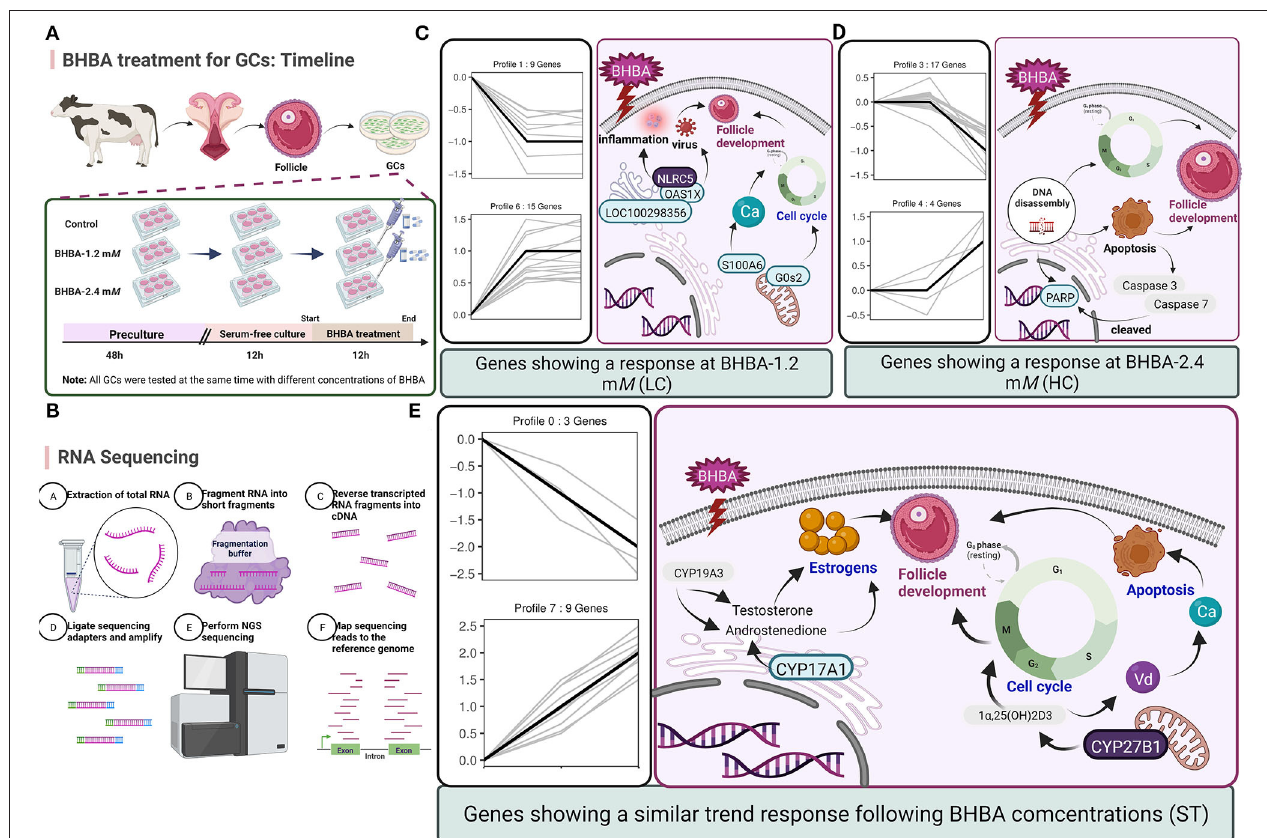
FIGURE 9 | (A) Timeline of BHBA treatment for GCs. (B) The process used for RNA-seq. (C–E) Predicting the regulatory effects on GCs and follicle development exerted by the major DEGs in three expression patterns (including LC response, HC response, and ST response). Up-regulated DEGs are shown in blue boxes while down-regulated DEGs are shown in gray